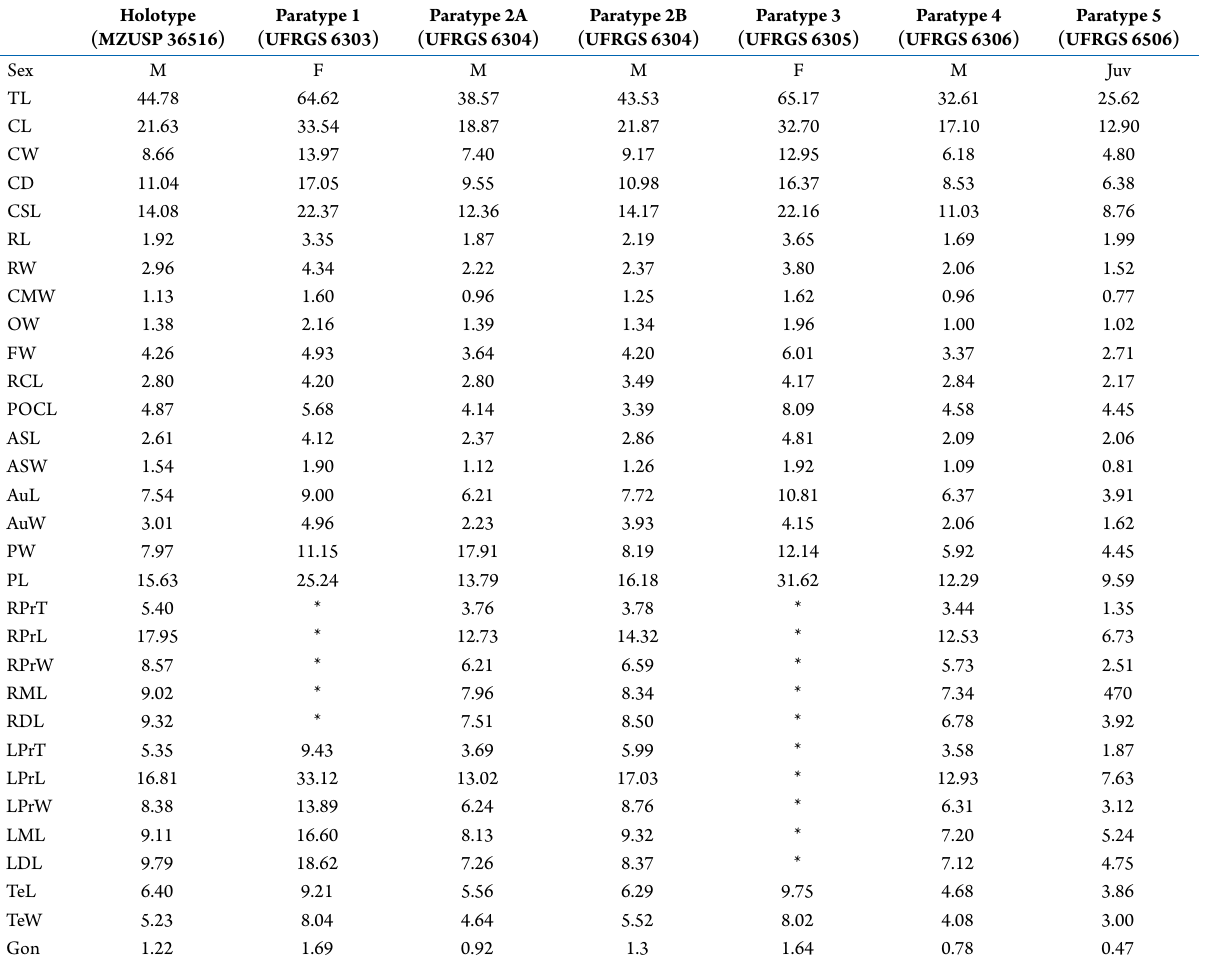
Table 2. Measurements (mm) of the type series of Parastacus pilicarpus sp. nov. (* broken appendage). For abbreviations see Material and Methods